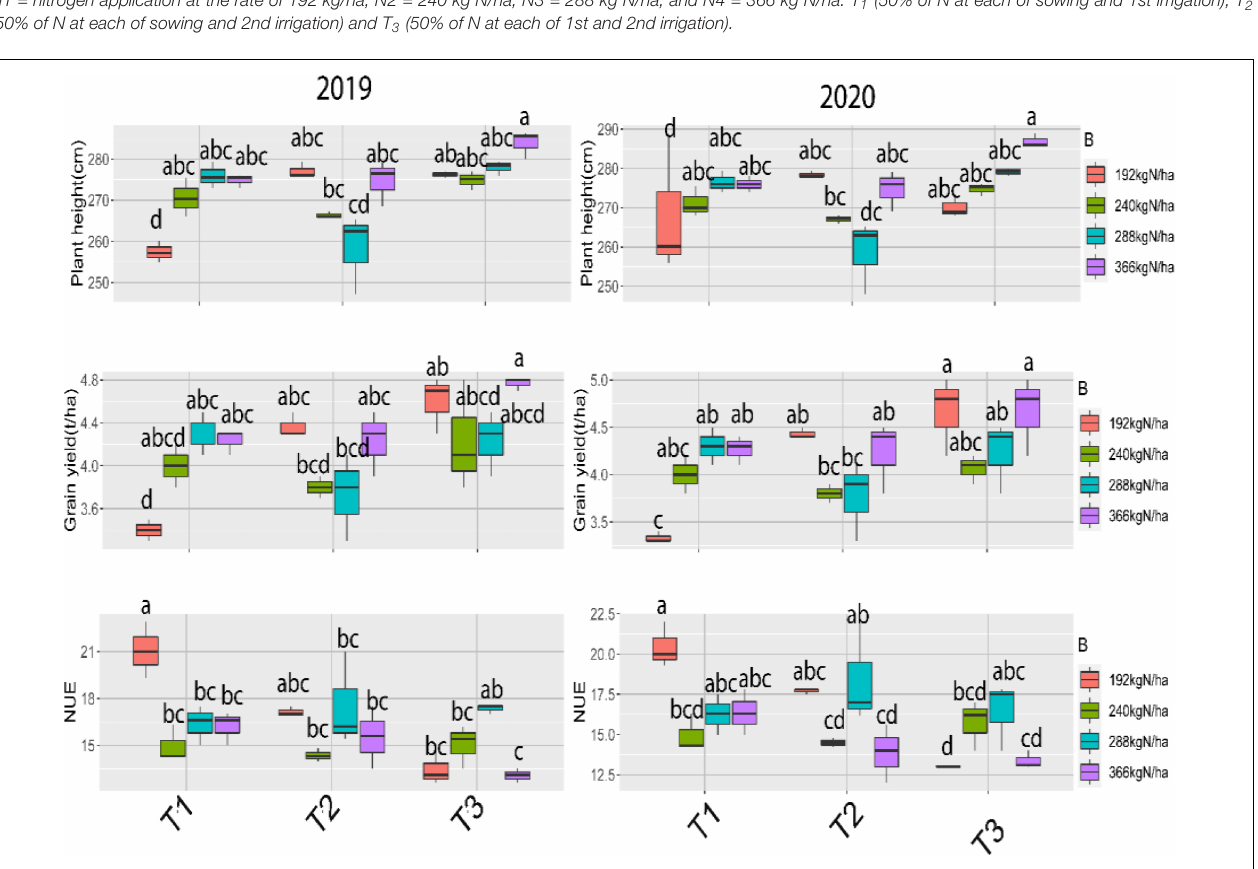
46.7 grains) were recorded with fertilizing maize plants by the higher rate of the nitrogen with T3 (50% of N at each of 1st and 2nd irrigation) also this rate with T 1 (50% of N at each of sowing and 1st irrigation) or T 2 (50% of N at each of sowing and 2nd irrigation) gave the highest numbers in the first and second seasons,